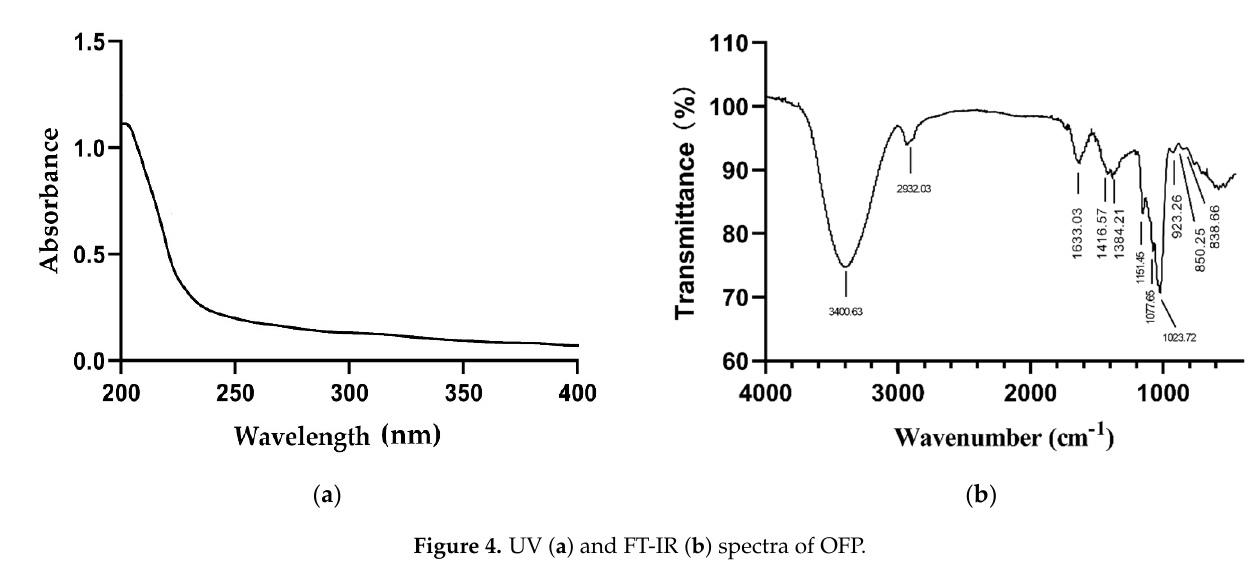
Figure 4. UV ( a ) and FT-IR ( b ) spectra of OFP.